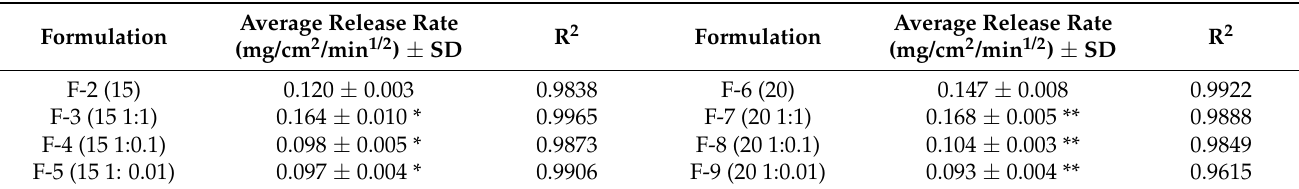
Table 4. ACTH release rate and fit using Higuchi’s model ( n = 6) in vitro condition; * p < 0.05 applies to F-2 (15 mg/g ACTH) and ** p < 0.05 applies to F-6 (20 mg/g ACTH).